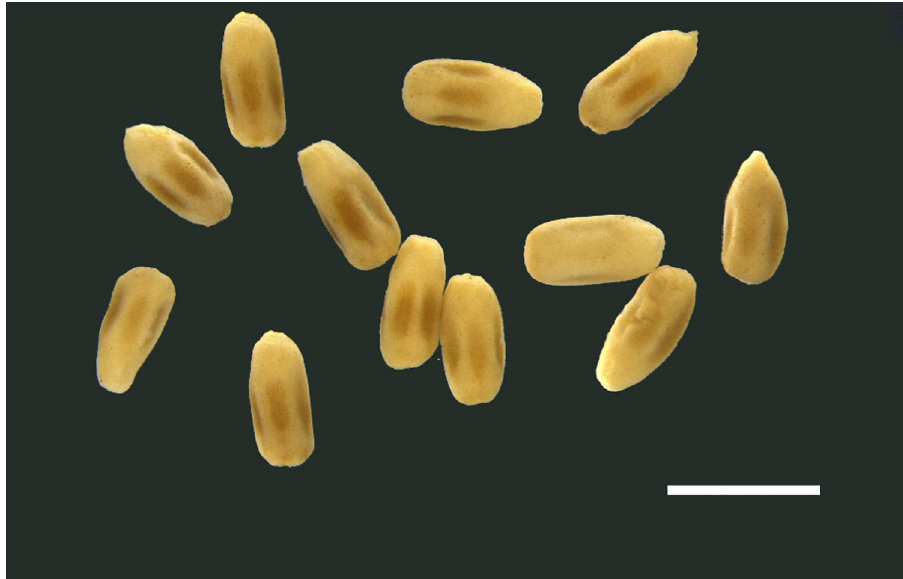
Figure S2. Dry pellets of P. macondianus sp. n. Scale bar 1